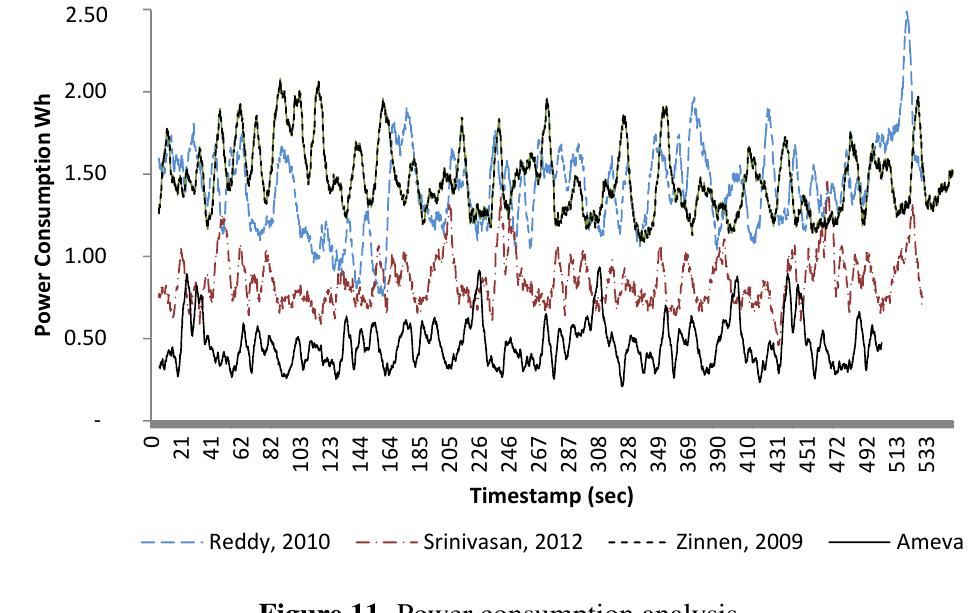
Figure 11. Power consumption